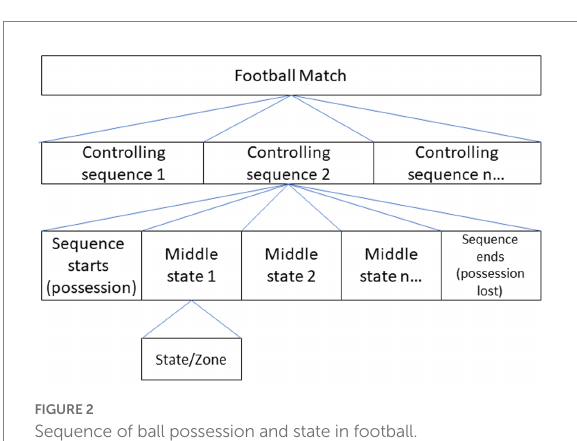
FIGURE 2 Sequence of ball possession and state in